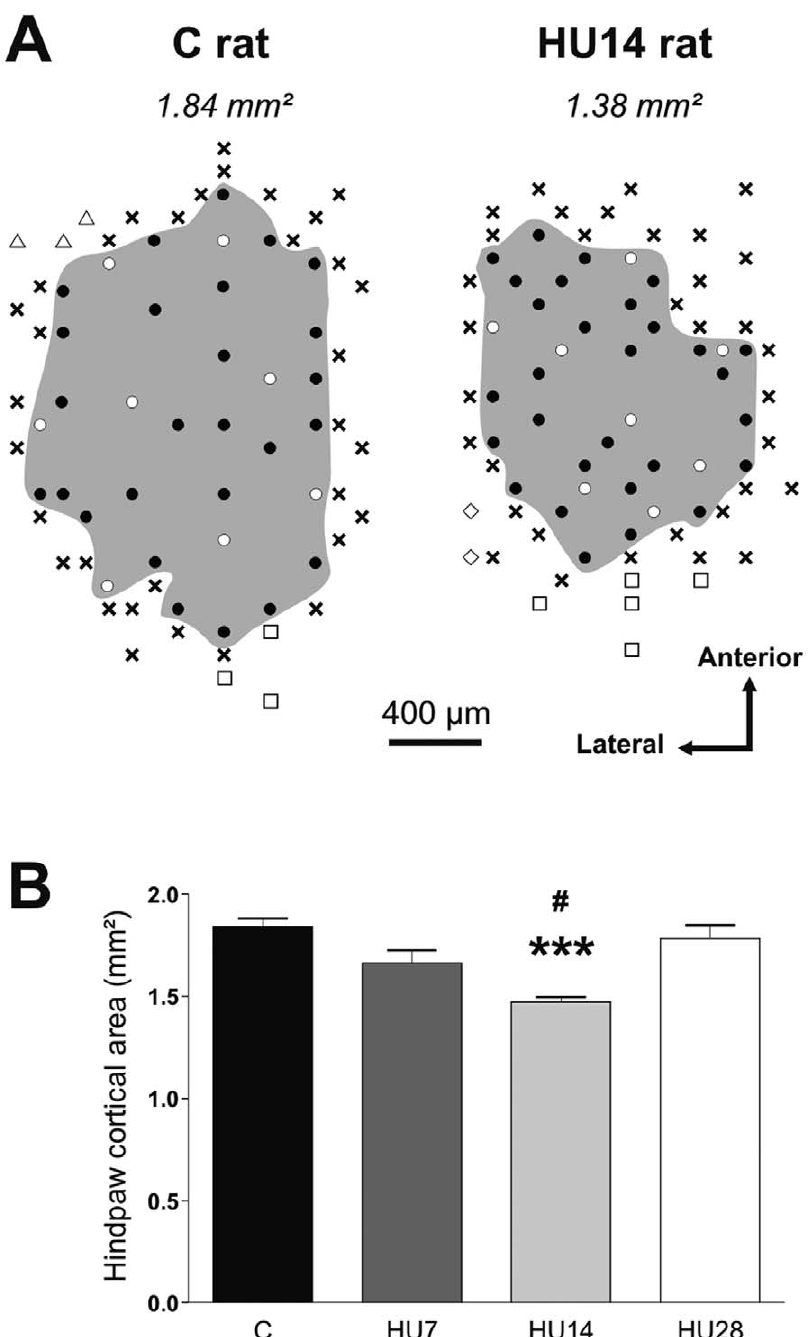
N Figure 1. Hindlimb unloading induces a reorganization of somatosensory hindpaw cortical area. (A) Representation of the hindpaw area and # indicate locations of penetrations where cortical neurons had hindpaw cutaneous in the somatosensory cortex for one C and one HU14 rats. receptive fields. # corresponds to the recording sites of the 8 cutaneous receptive fields presented in figure 2. 6 indicates penetrations where neurons were not responsive to cutaneous stimulation. The grey area shows the cortical representation of the hindpaw (values expressed in mm 2 on top). The penetration sites for adjacent body regions are represented by n (forelimb), % (hindlimb) and e (trunk). (B). Mean value of the hindpaw cortical area for C and HU-x groups. indicates a significant difference between C and HU14 groups ( P , 0.001), and # between HU14 and HU28 groups ( P , 0.05). doi:10.1371/journal.pone.0017564.g001 + 0.4% respectively, ns ) on the extent of hindpaw representation on p , 0.05). Values in HU14-PD98059 rats were higher to that observed the cortex. In HU14 rats, PD98059 infusion dramatically increased in C animals ( + 27.9%, p , 0.001). The two-way ANOVA reveals a Substance effect ( F =13.56, p , 0.001) and a Group x Substance interaction the hindpaw cortical area ( + 51.2%, p , 0.001) (Figure 5A). It should be noted that vehicle slightly affected the cortical map ( + 18.4%, ( F =13.09, p , 0.001). PLoS ONE |